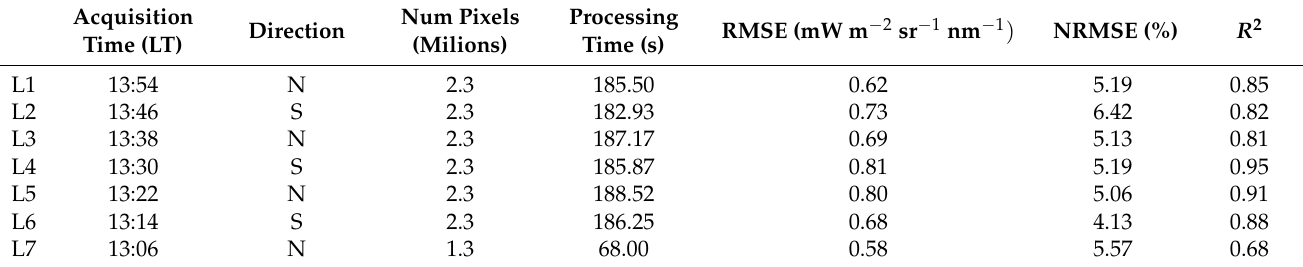
Table 4. Goodness-of-fit statistics obtained for the emulated SIF maps of all flight lines. The evaluation has been carried out by comparing the emulated SIF values with the corresponding values of SFM SIF maps on pixel